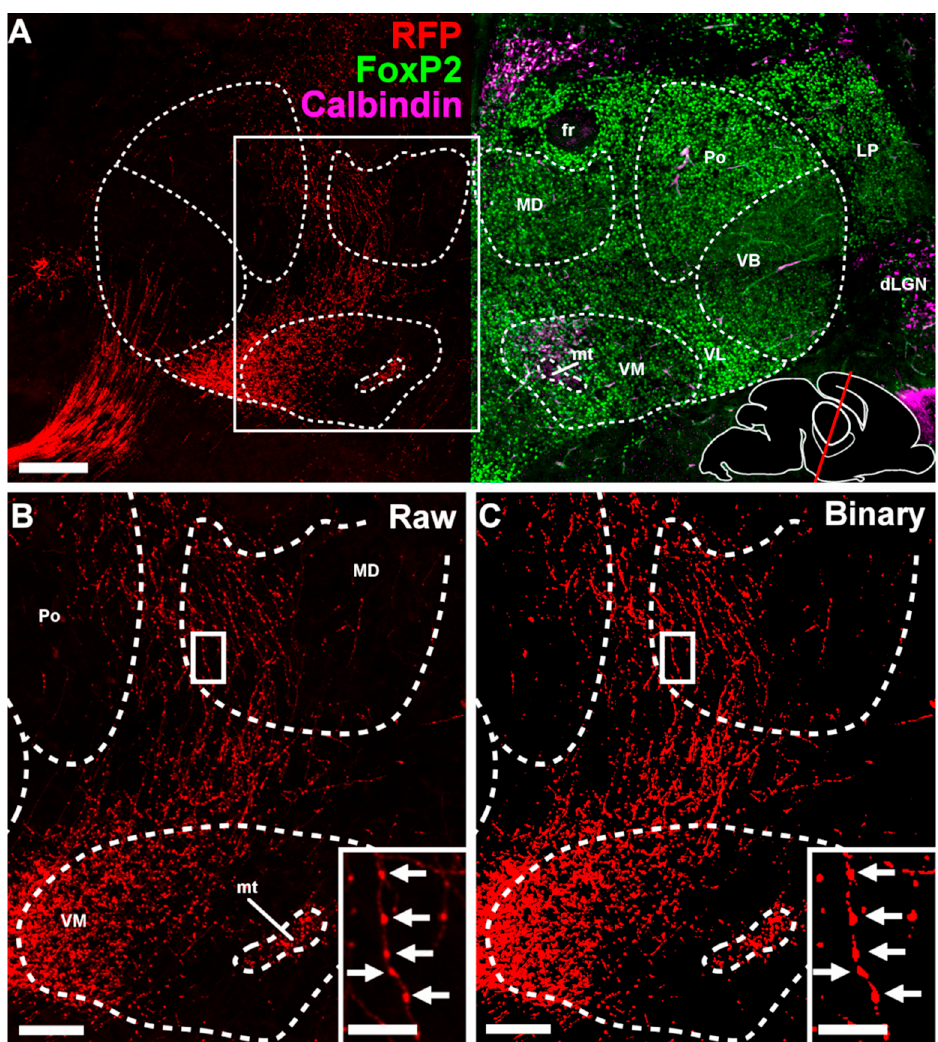
Figure 4. RFP + fibers in the diencephalon at E18.5. ( A ) Coronal section of an E18.5 mouse brain stained for FoxP2 (in green), calbindin (magenta) and Red Fluorescent Protein (in red) showing an example of delineation of the ventromedial (VM), posterior (POm), mediodorsal (MD), ventrobasal (VB), ventrolateral (VL), lateral posterior (LP) and dorsal lateral geniculate (dLGN) nuclei, the fasciculus retroflexus (fr) and the mamillothalamic tract (mt). Bottom right shows a schematic showing the angle and rostro-caudal level of the coronal section. ( B ) Zoom in of boxed region in ( A ). In the inset, a single axon with multiple putative boutons is visible. Arrows indicate the putative boutons. ( C ) Binarized version of B after applying the threshold. Inset is a binarized version of the inset in C. Scale bars: A = 200 µm; B and C = 100 µm, insets = 25 µm.